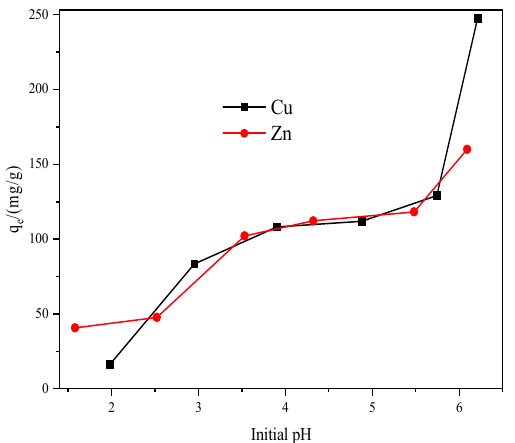
Figure 9. Effect of initial pH on the adsorption capacity of X zeolite for Cu 2+ and Zn 2+ .